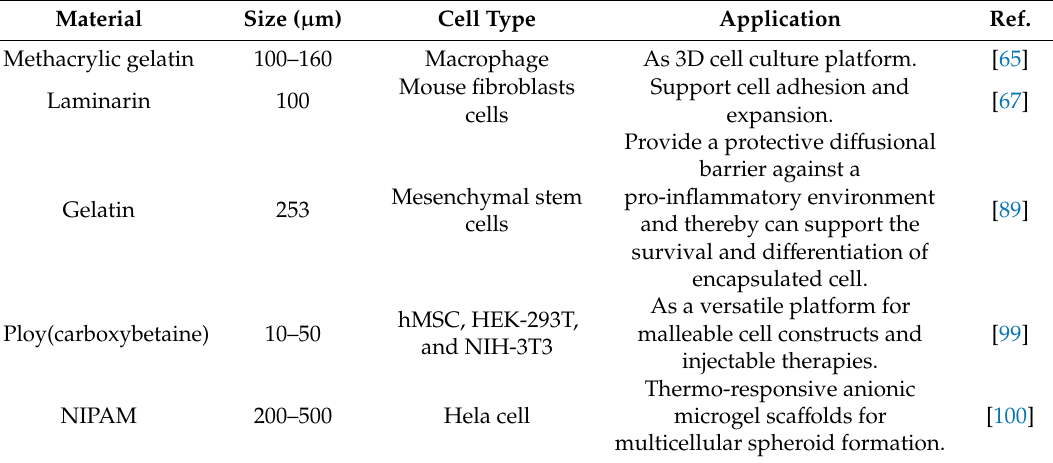
Table 3. Microgels and their applications as cell